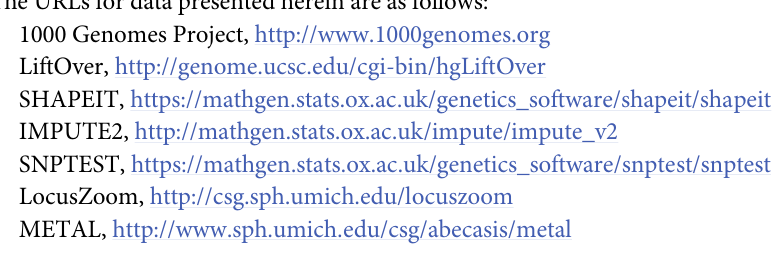
S1 Table. Neuroblastoma patient characteristics.